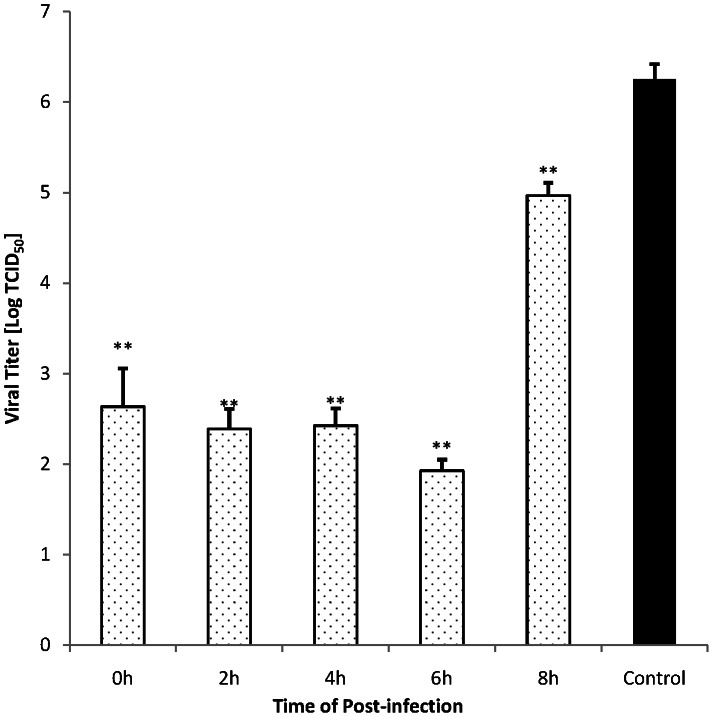
Influence of administration timing of resveratrol on virus infection.DEFs were incubated with DEV (100TCID50) for 1 h at 37°C. Resveratrol solution was added to the cells after inoculum removal at indicated time points (0, 2, 4, 6, and 8 h p.i.) at a concentration of 31.25 μg/mL. After incubation for 24 h, antiviral activity was evaluated by the virus yield reduction assay. Values are means ± SD (n = 3). Significance: **P<0.01 vs. non-drug treated control group.